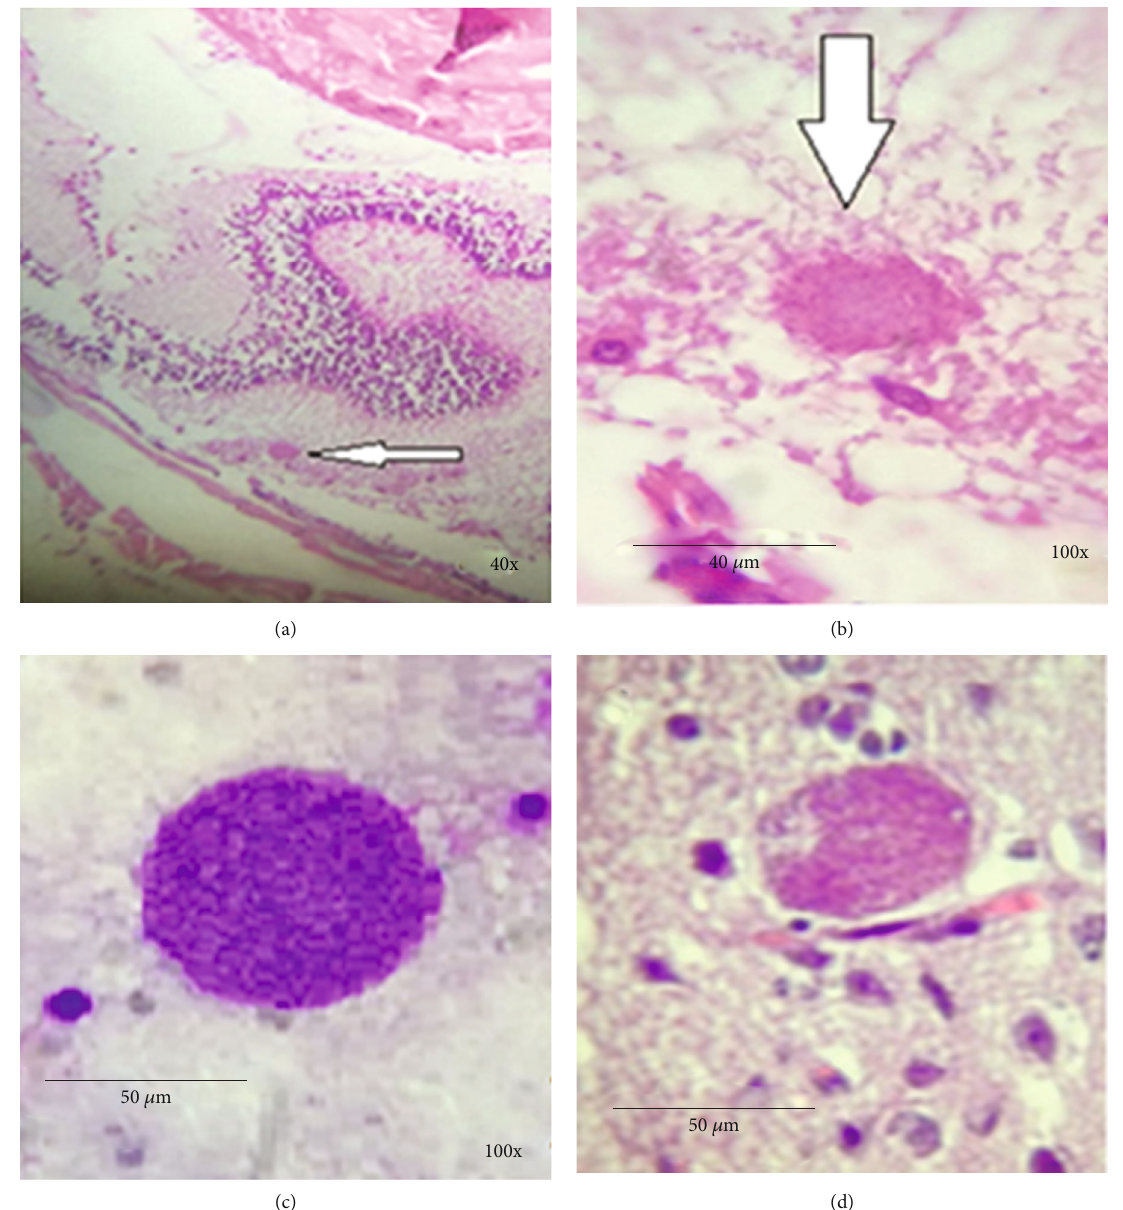
Figure 1: Toxoplasma cysts in the sample groups: (a) eye tissue cyst in mice within 50 days after parasite infection, stained with H&E staining and 400x magni fi cation, (b) the same cyst at 1000x magni fi cation, (c) the tissue cyst in impression smear of infected mouse brain stained with Giemsa staining and 1000x magni fi cation, and (d) the tissue cyst in brain of infected mice stained with H&E staining and 1000x magni fi